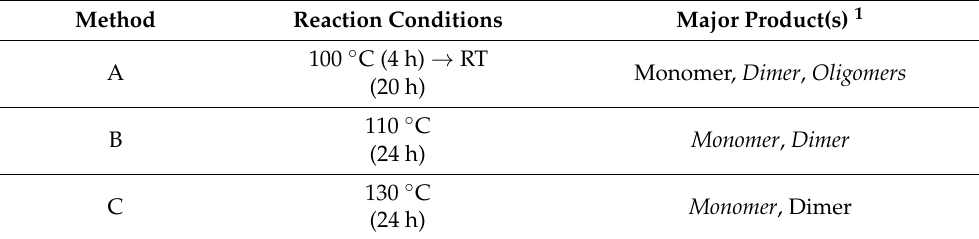
Table 1. Reaction conditions and major products obtained during aminolysis.